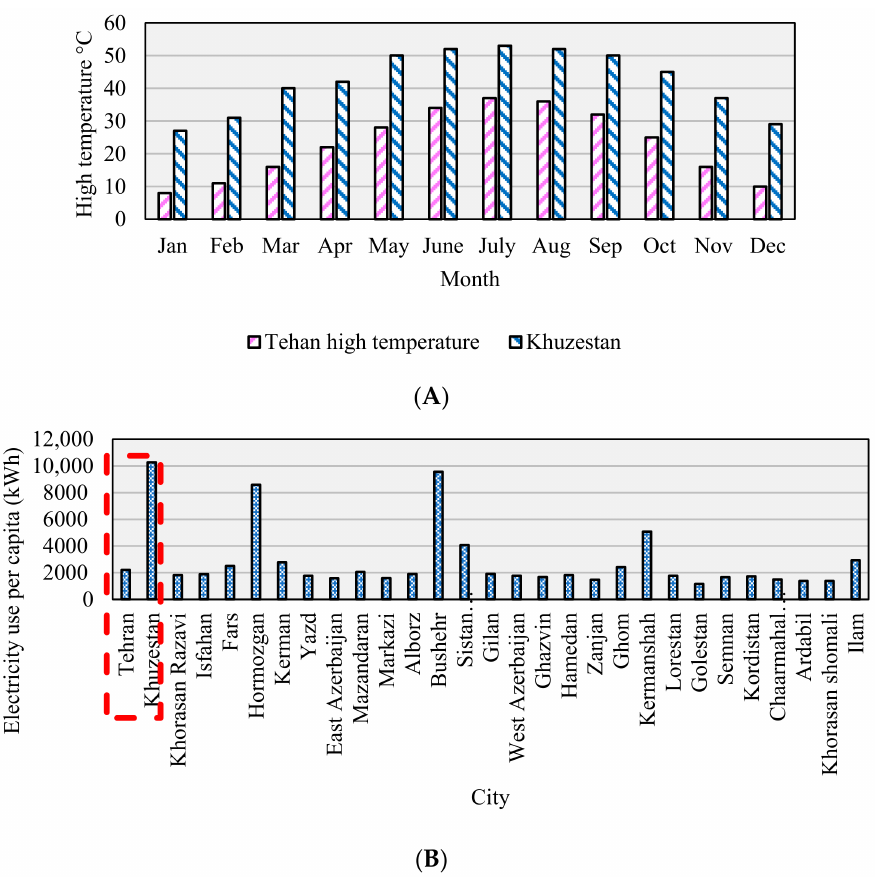
Figure 23. Comparison between Tehran and Khuzestan. ( A ) Monthly highest temperature; ( B ) elec- tricity use per